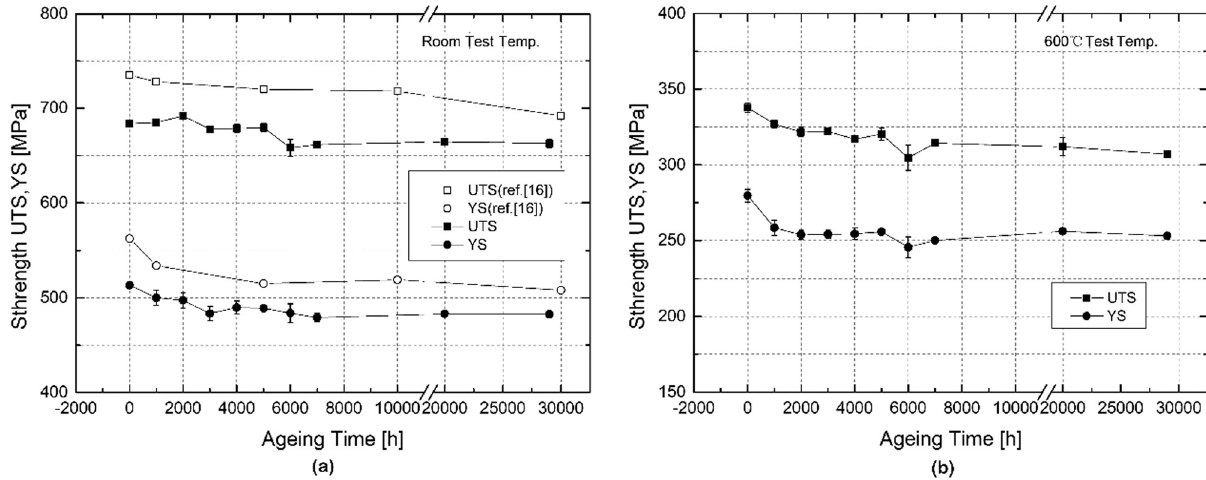
Figure 7: ( a ) Variations of static tensile properties examined at room temperature during the long - term aging exposure of 650°C. ( b ) Variations of static tensile properties examined at 600°C temperature during the long - term aging exposure of